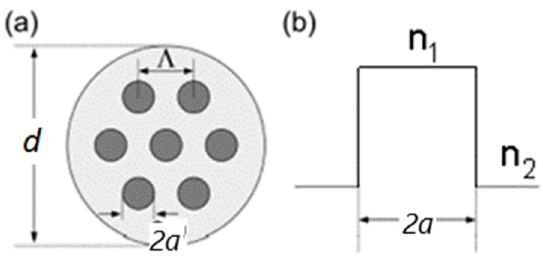
Figure 1. Schematic of ( a ) the cross section of MC PCSF, and ( b ) the index profile of the core struc- ture.